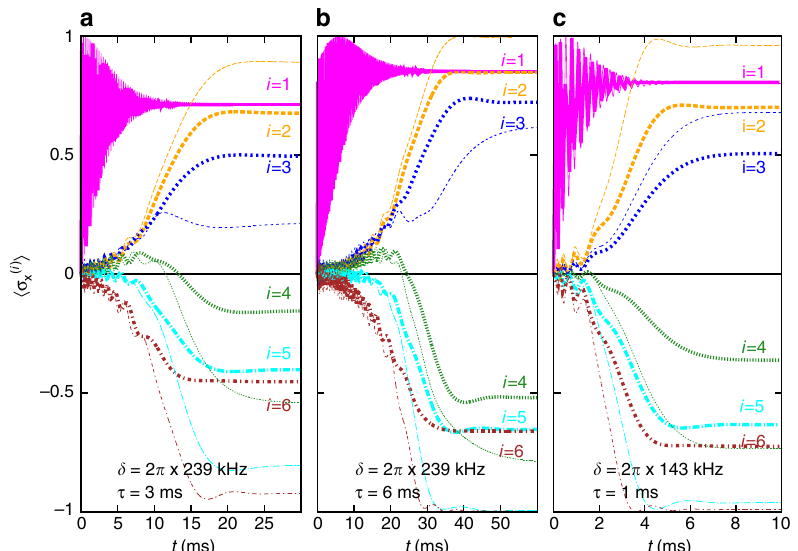
Figure 4 | Simulated quantum annealing in the closed system. Unitary time evolution of the full system ( N ¼ 6) for different laser detunings d between the fourth and fifth resonance. Thick lines show the result of the exact evolution, while the thin lines have been obtained from the semi-classical approximation. In all cases, the desired pattern ( þ þ þ (cid:3) (cid:3) (cid:3) ) can be read out after sufficiently long annealing times. While in a , b we operate at the onset of glassiness, d ¼ 2 p (cid:2) 239kHz, c considers a ferromagnetic instance, d ¼ 2 p (cid:2) 143kHz. The annealing protocol in a is defined by B max ¼ 50 J rms and t ¼ 3ms. In b the same instance is solved with higher fidelity by choosing B max ¼ 80 J rms and t ¼ 6ms. Fast annealing, with B max ¼ 50 J rms and t ¼ 1ms, is possible in the ferromagnetic instance in ( c ). In all simulations, we have chosen O ¼ 2 p (cid:2) 50kHz, o recoil ¼ 2 p (cid:2) 15kHz, and E ¼(cid:3)